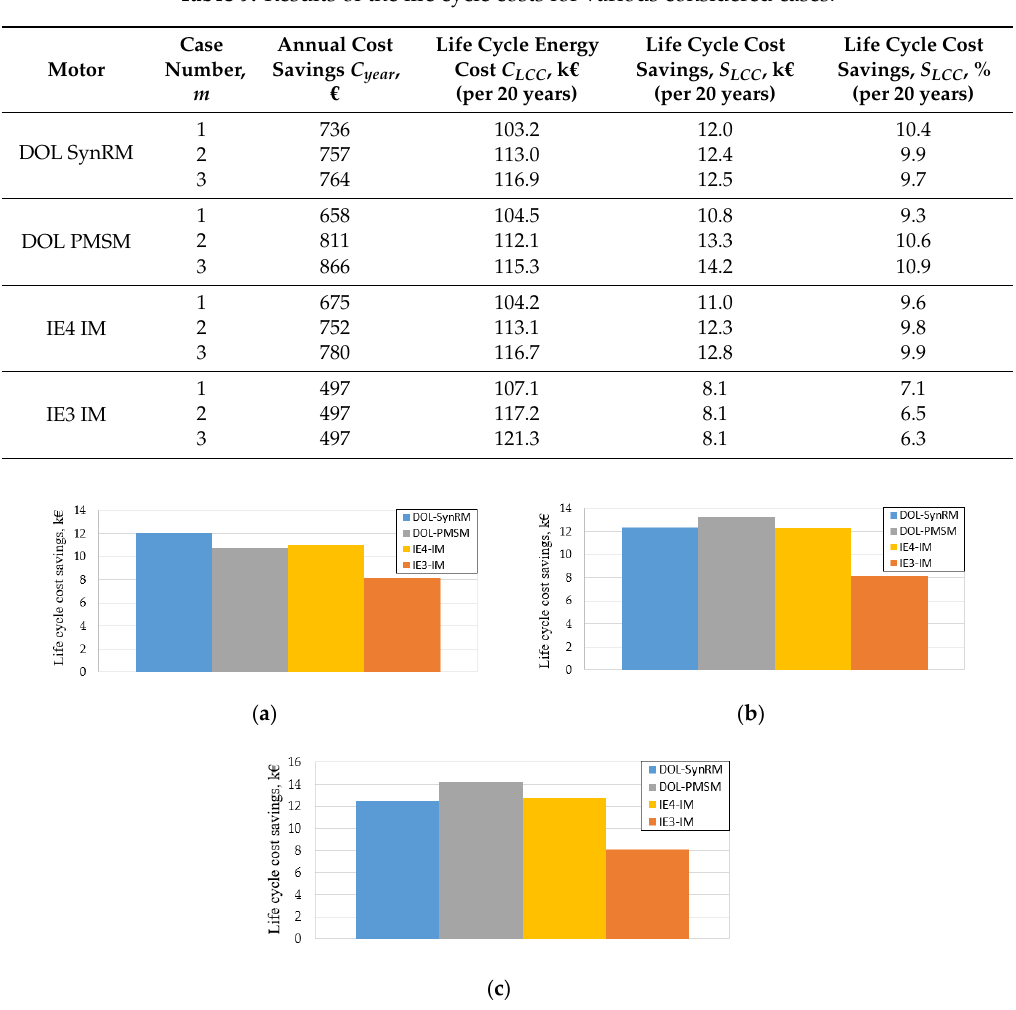
Table 9. Results of the life cycle costs for various considered cases.